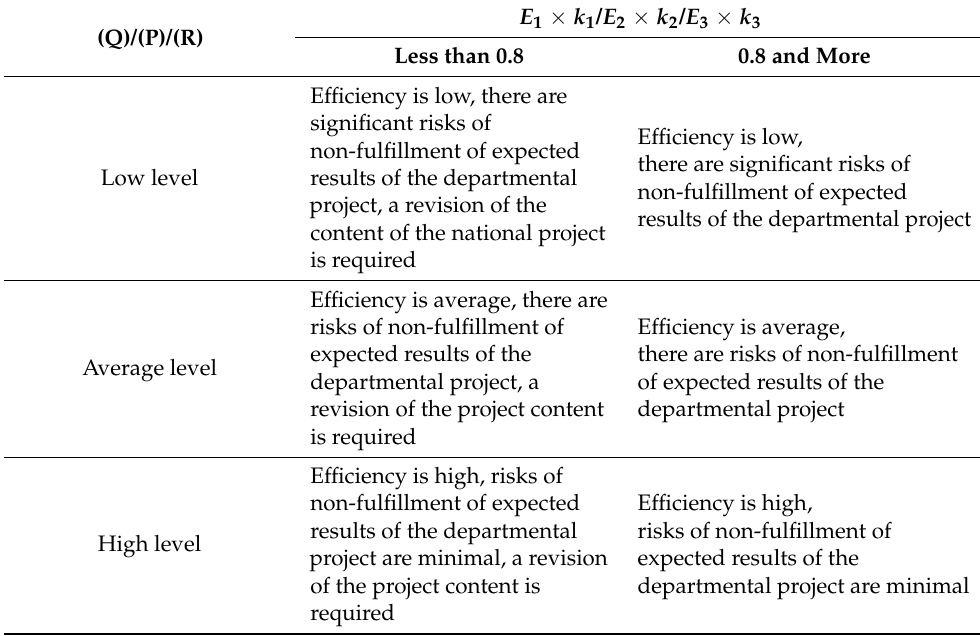
Table 4. Evaluation of the effectiveness of the implementation of the institutional